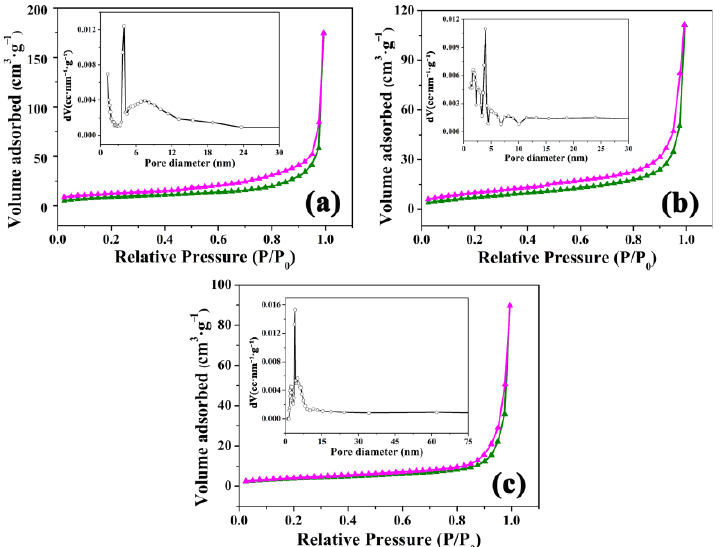
Figure 6. Nitrogen adsorption/desorption isotherm and the Barrett – Joyner – Halenda (BJH) pore-size distribution plot (inset) of C@Fe 3 O 4 composites ( a ) nanorod, ( b ) nanodisk and ( c ) nano- particle.